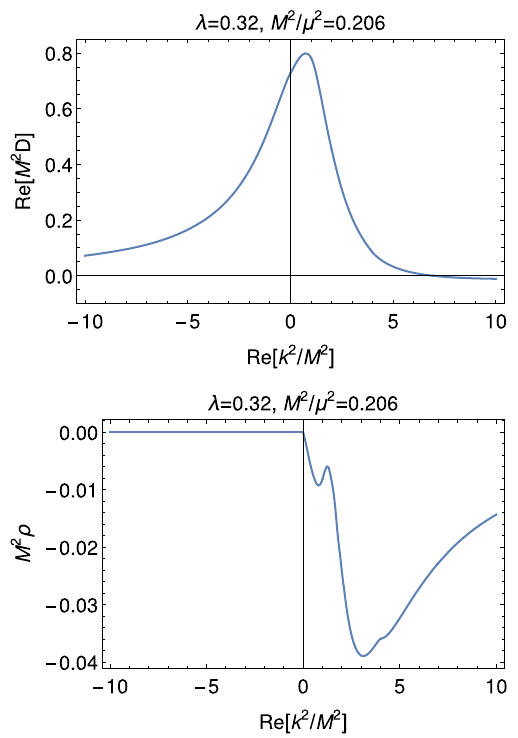
Fig. 17 The gluon propagator D ( k 2 ) as a function of k 2 restricted on the real axis k 2 ∈ R , (top) the real part Re D ( k 2 ) , (bottom) the scaled imaginary part Im D ( k 2 + i (cid:10))/π which is equal to the spectral function ρ( k 2 ) , at the physical point of the parameters λ := Ng 2 /( 4 π) 2 = 0 . 32, M 2 /μ 2 = 0 .